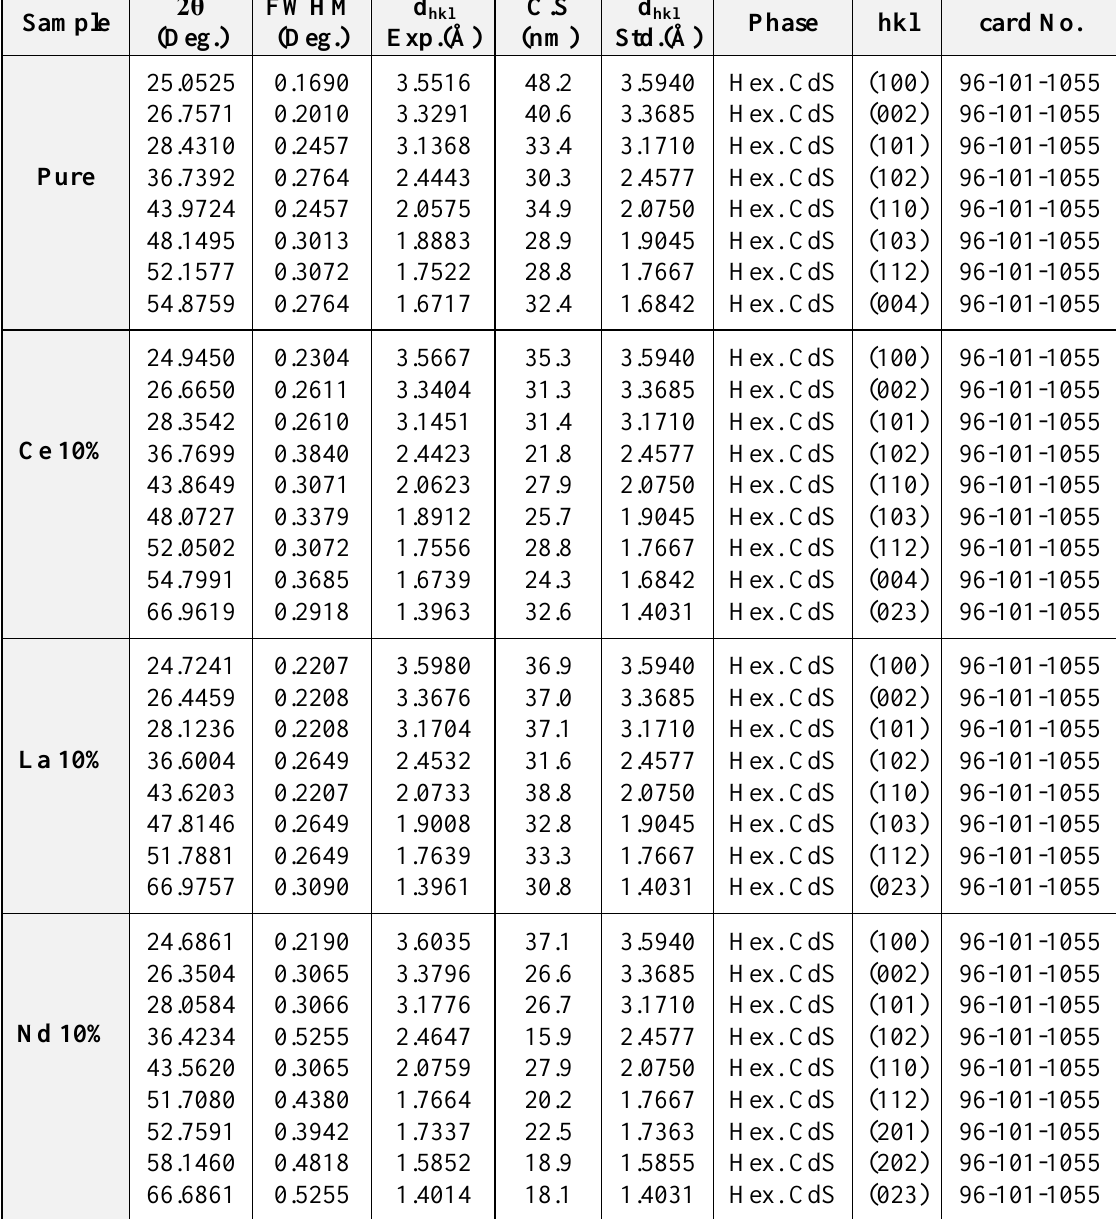
Table 1: Structural parameters for pure CdS and and (Ce, La and Nd) doped CdS at 10%. Sample